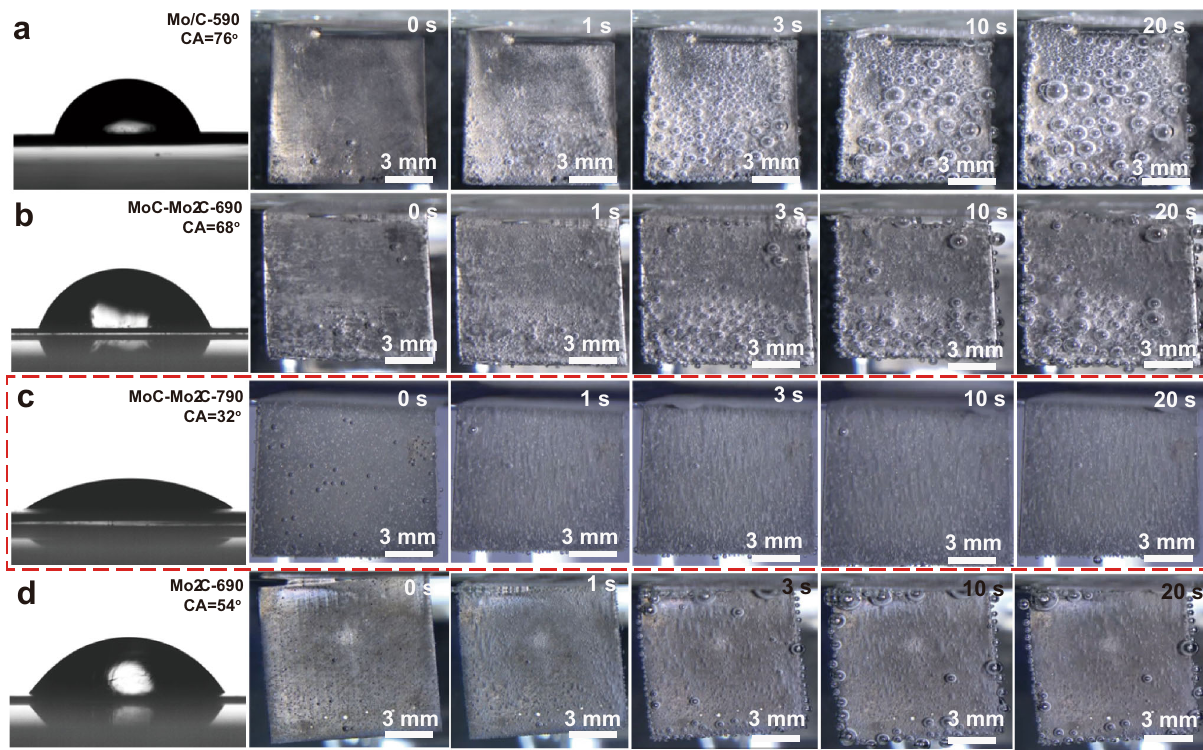
Fig. 4 Contact angle images between water and electrodes and the bubble evolution process on the surface of electrodes. a The Mo/C-590 electrode. b The MoC-Mo 2 C-690 electrode. c The MoC-Mo 2 C-790 electrode. d The Mo 2 C-890